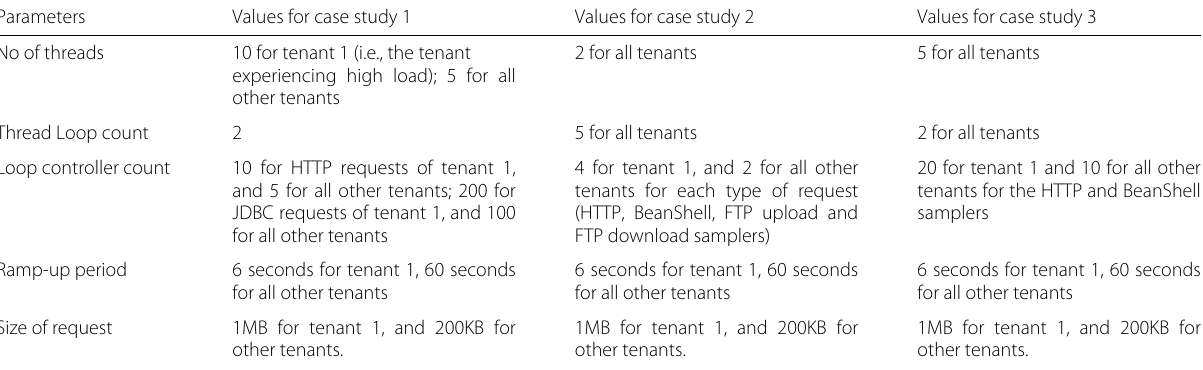
Table 2 Setup parameters used in the experiments Parameters Values for case study 1